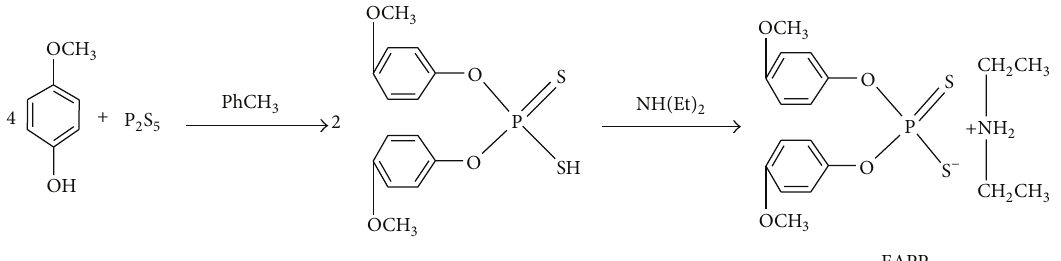
Figure 1: Synthesis and molecular structure of the investigated inhibitor.